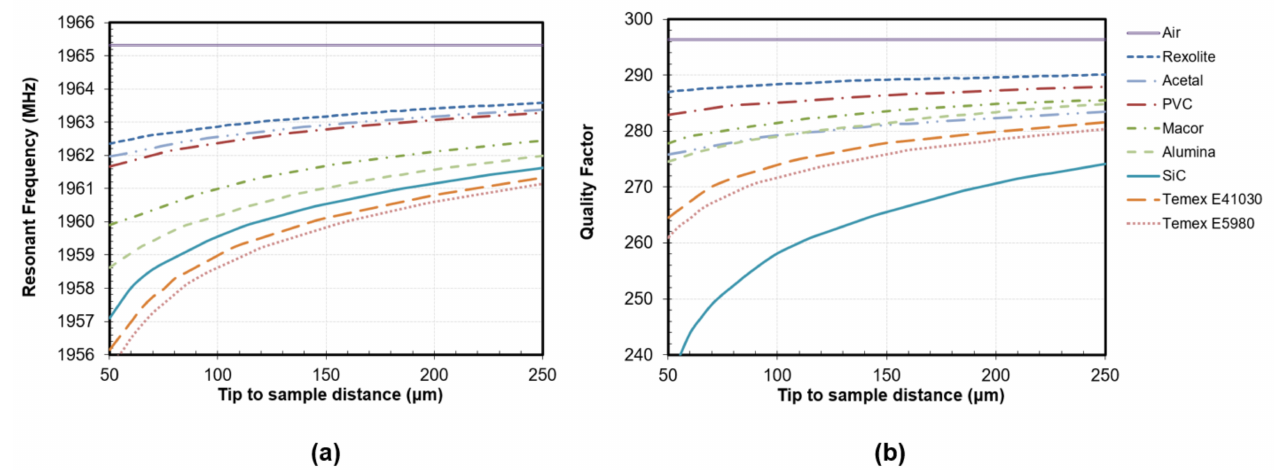
Figure 3. Response of the sensor as a function of the tip-to-sample distance for different reference materials: ( a ) resonant frequency; ( b ) unloaded quality